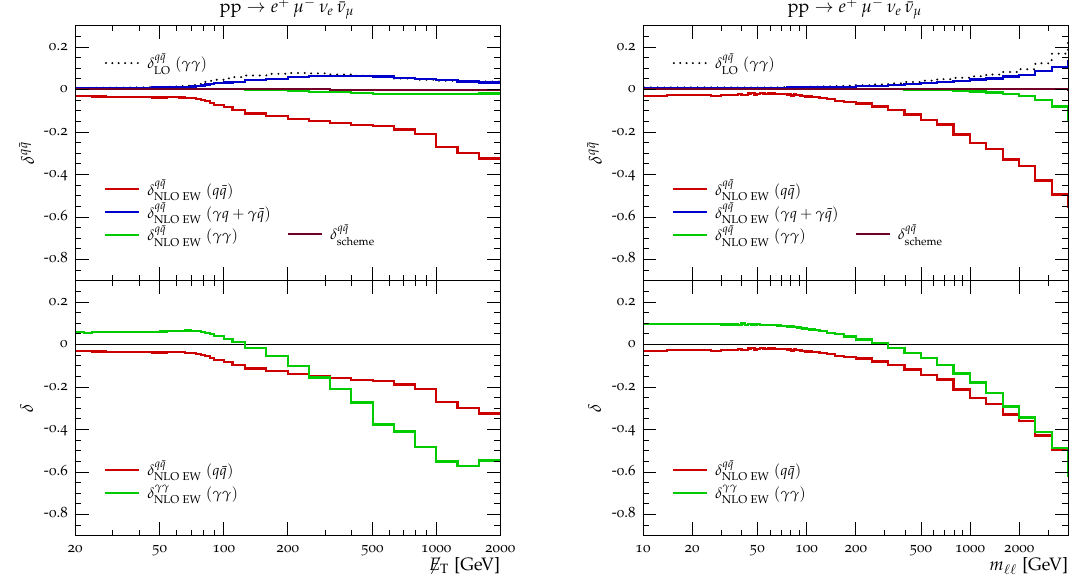
Figure 24 . Relative corrections in the missing transverse momentum, of the e + (cid:22) (cid:0) pair, m ‘‘ , for pp